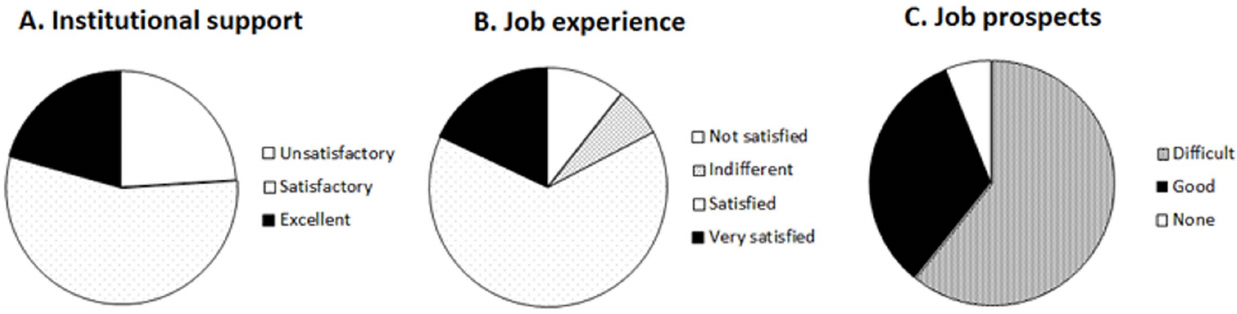
Figure 1. Summary of PDRs’ responses about their work environment and expectations. (A) Institutional support, (B) Job experience, and (C) Job prospects.